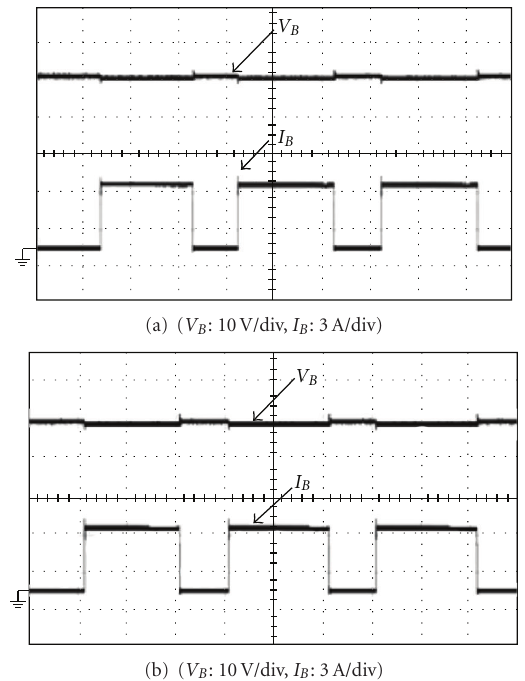
Figure 18: Battery voltage V B and charging current I B under step- load changes between 20% and 100% of full load of the discussed interleaving boost converters with (a) hard switching (b) a single- capacitor turn-o ff snubber.